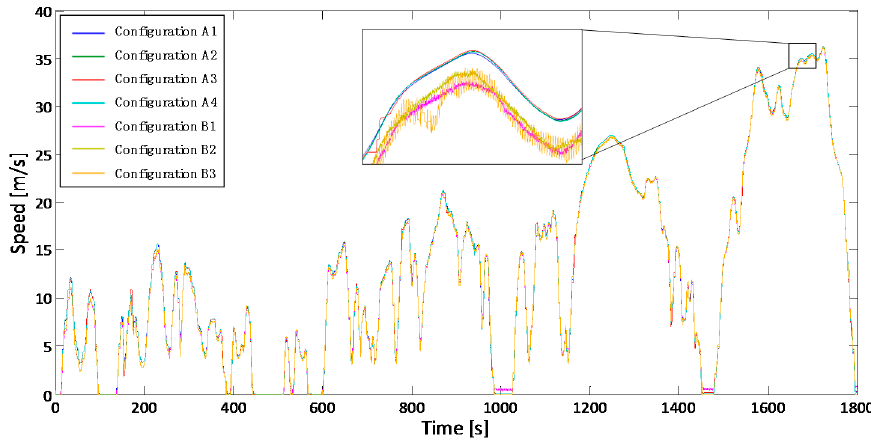
Figure 10. Speed response of fuel cell powertrain system under different configurations. Energies 2018 , 11 , x